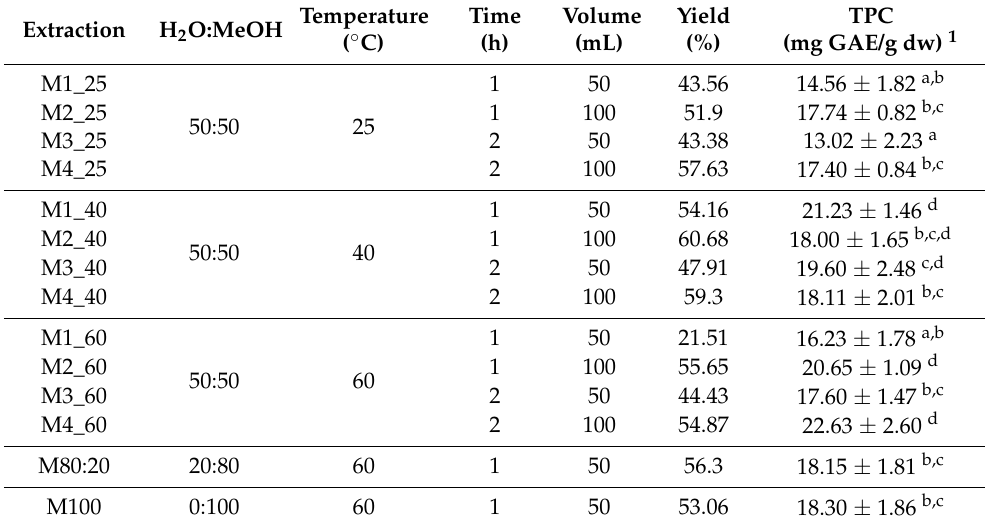
Table 1. Preliminary study on extraction conditions and obtained yields. M—mango peels.